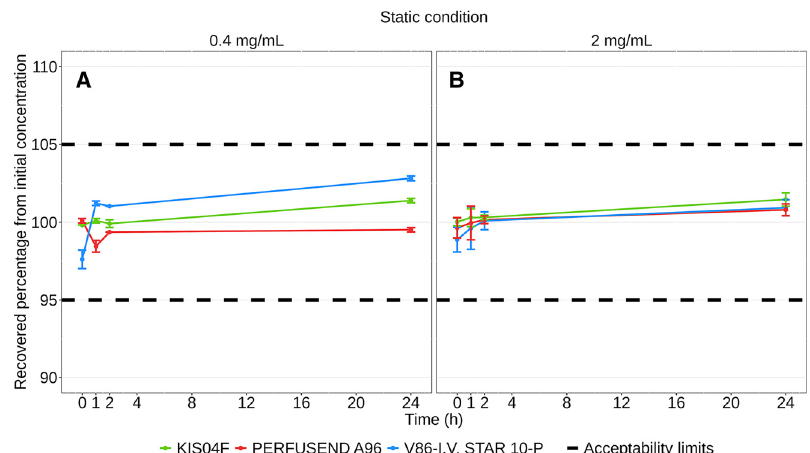
Figure 1: Evolution of infliximab concentrations (mean ± 95% con fi dence interval, n=3) quanti fi ed by size exclusion chromatography at 0.4 mg/mL (A) and 2 mg/mL (B) during 24 h of static